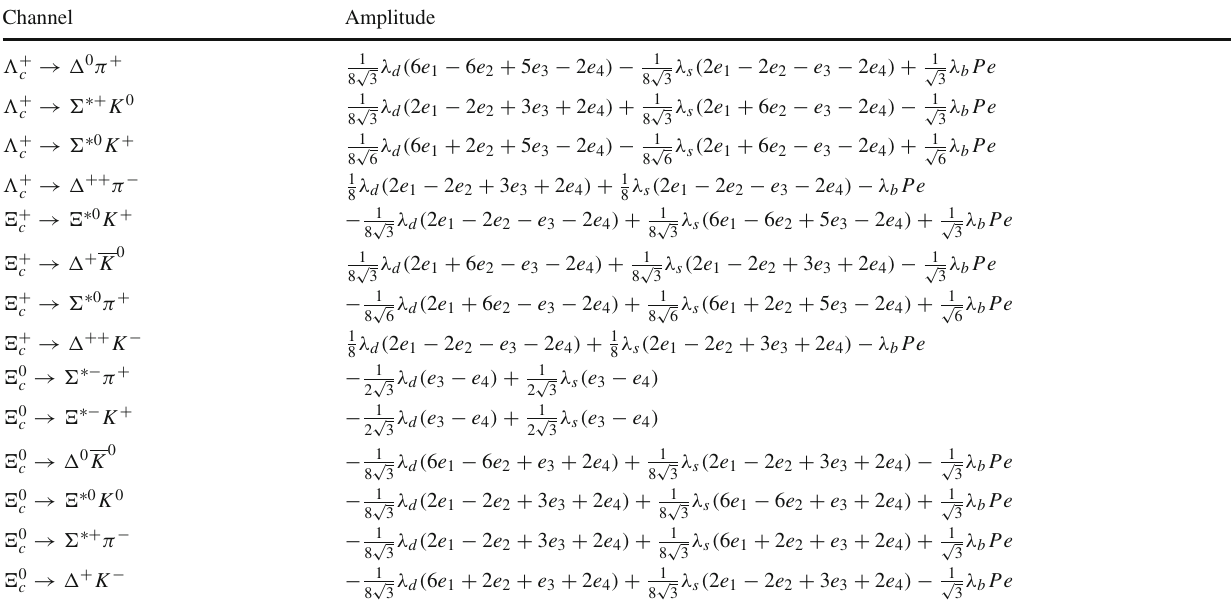
Table 1 SU ( 3 ) irreducible representation amplitudes in B definite U -spin quantum numbers are listed Channel